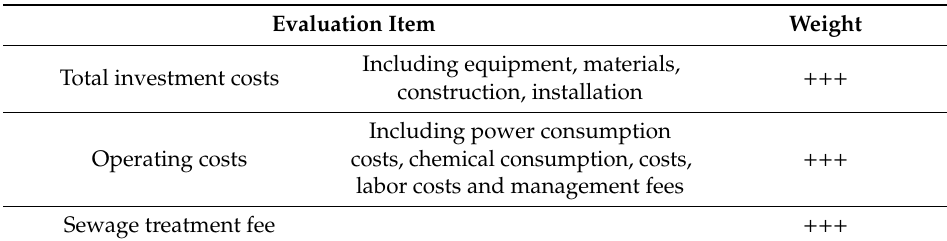
Table 8. Economic indexes of the ultrafiltration membrane system-based WWTP renovation methodology